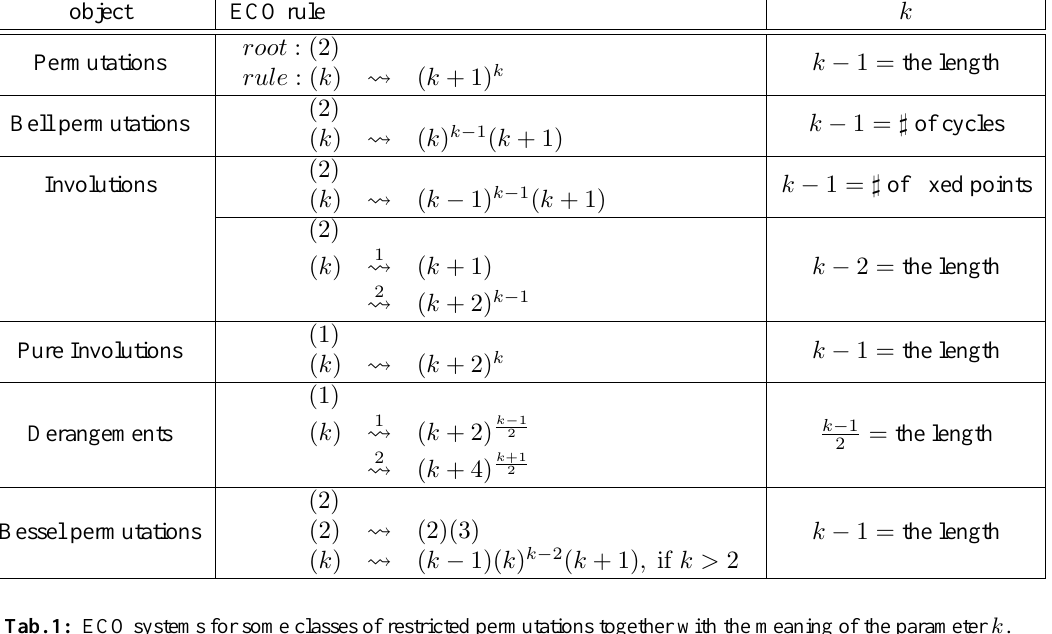
Tab. 1: ECO systems for some classes of restricted permutations together with the meaning of the parameter k . expression for τ , i covers { 1 , 2 , . . . , n − 2 } so does π − 1 ( i ) , and replacing π − 1 ( i ) by i this